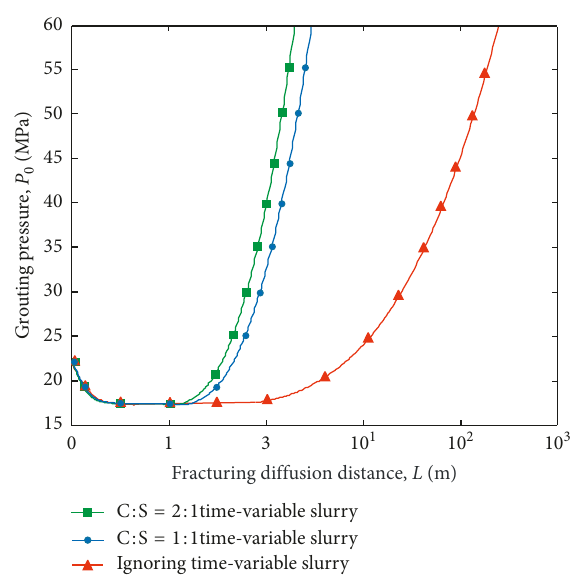
Figure 7: The influence of the viscosity-time denaturation on the slurry splitting diffusion distance.